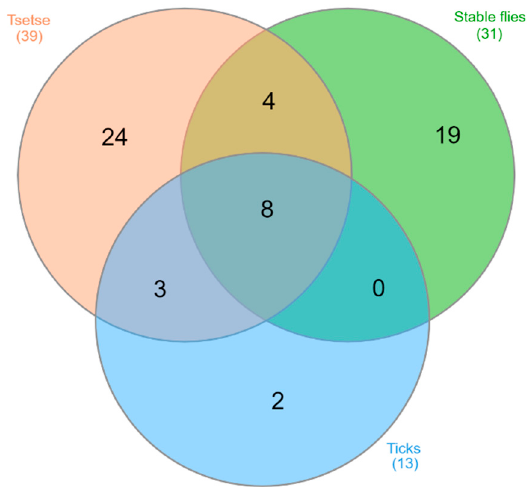
Figure 3. Number of bioactive volatiles from bovine rumen odour that have been shown to stimulate electrophysiological and/or behavioural activity in tsetse fly (39), stable fly (31), and tick (13) species. Numbers in parentheses indicate the total number of allelochemicals in rumen emissions for each pest type; numbers in compartments of the figure show the chemicals with allelochemical function that are shared by different arthropod taxa [138].